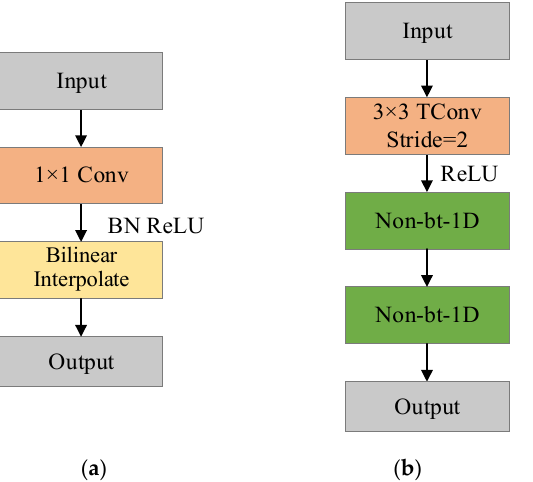
Figure 5. The specific structure of the two upsampling modules. ( a ) Bilinear interpolation upsampling. ( b ) Transposed convolution upsampling.